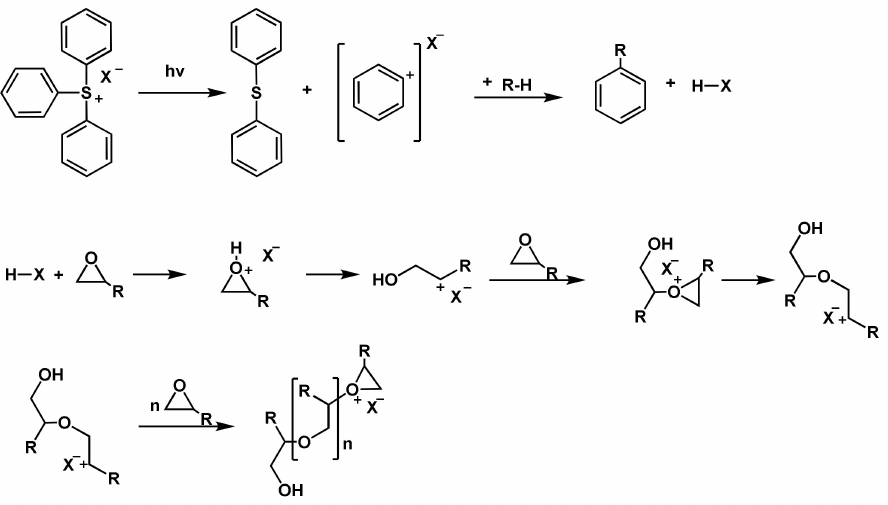
Figure 12. Reaction mechanism of the cationic ring-opening polymerization of